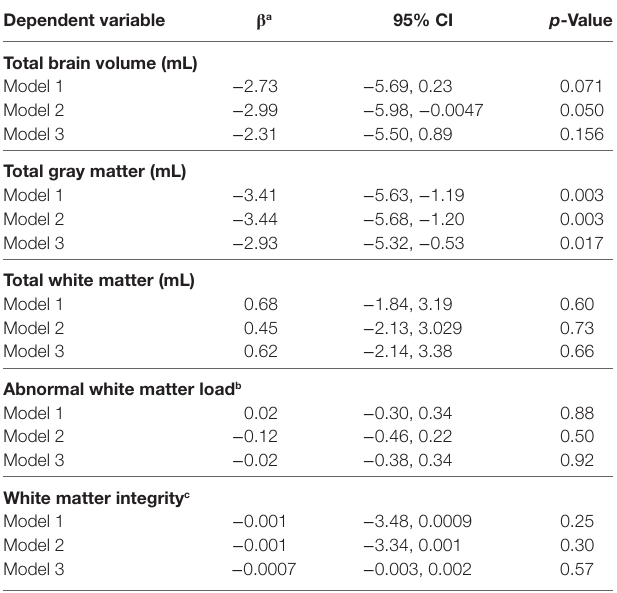
TaBle 2 | Log(NT-proBNP) and global brain volumes in the CARDIA brain magnetic resonance imaging sample.